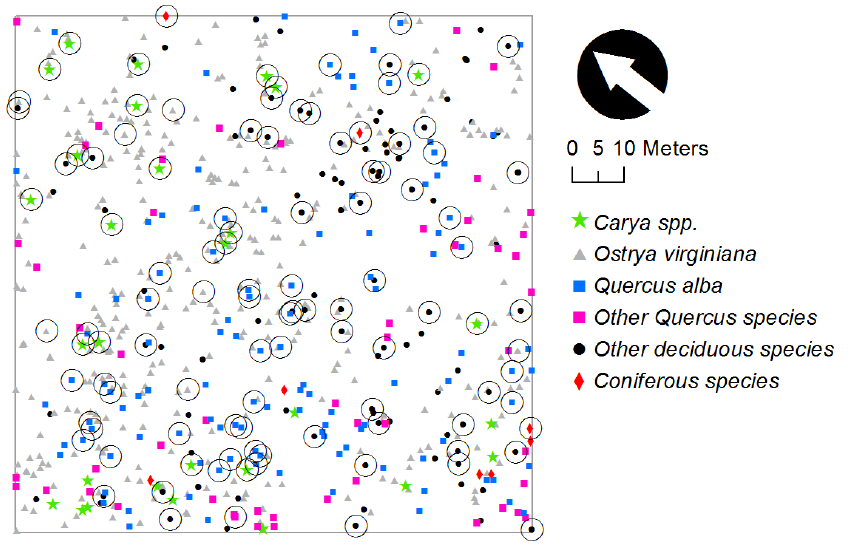
Figure 5. Map of the harvest tree locations (circled) assuming unique tree species in the species mingling index computations, for the uneven-aged oak-hickory stand in Georgia (eastern United States). The initial threshold was 0.004; the rate of change was 0.9975; and the iterations per threshold were